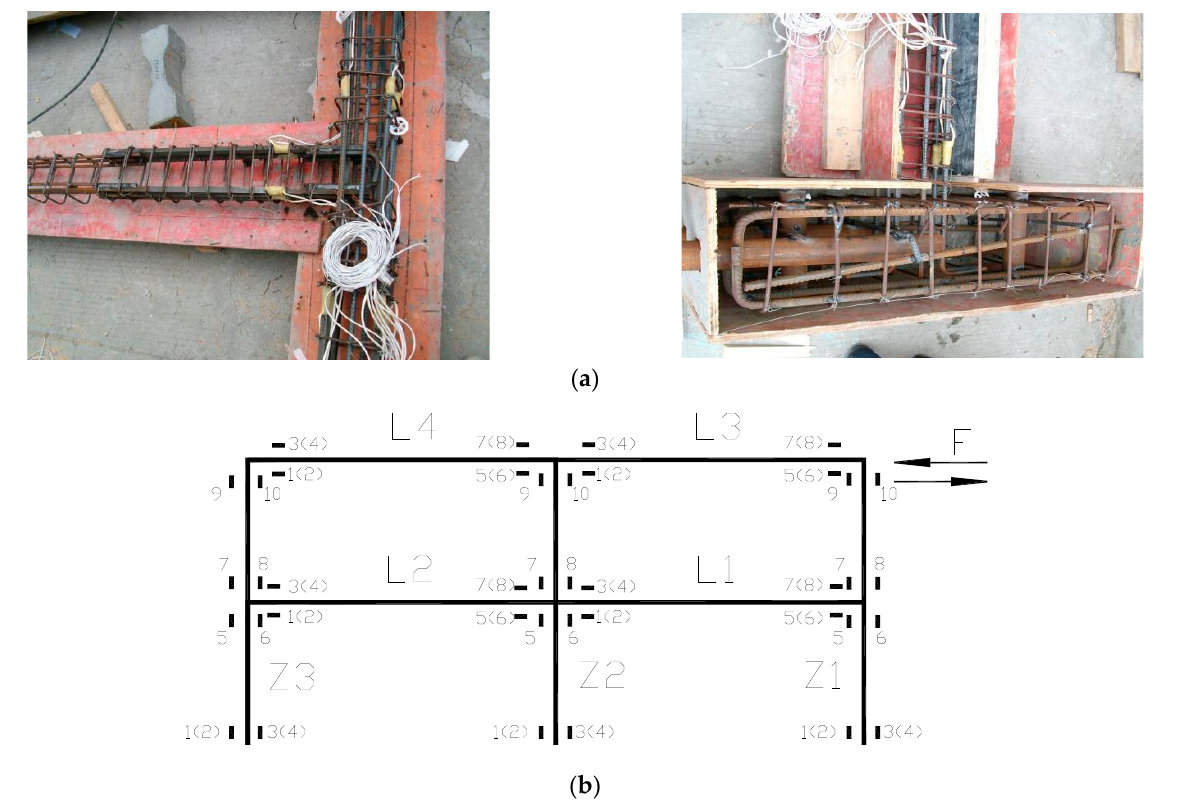
Figure 4. Arrangement of strain gauges. ( a ) Accomplished strain gages. ( b ) Schematic view of strain gages sticking.